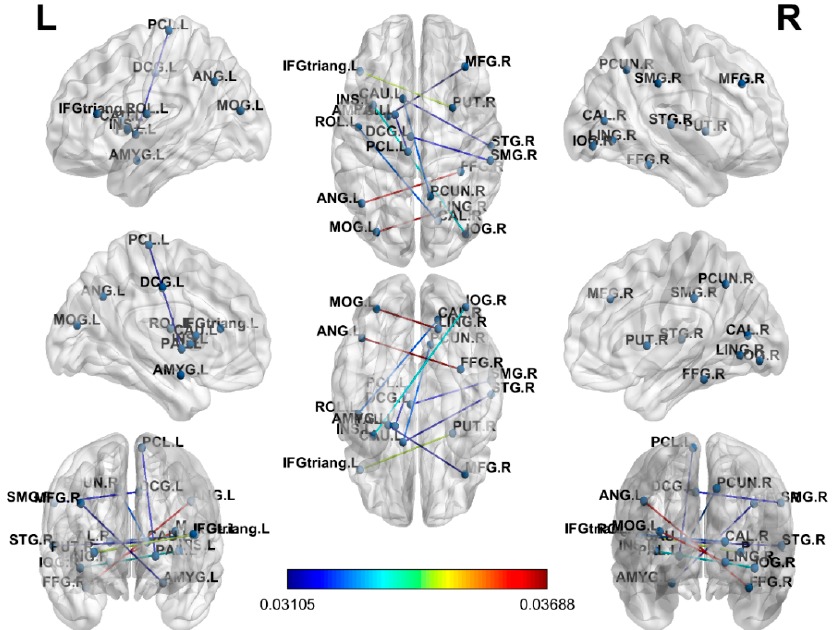
Figure 2. The weighted coefficients of the structural connections in the LR model. Warmer colors represent higher absolute values of the LR coefficients. A threshold of 0.03105 was set to reduce the connections for visual presentation. R: right; L: left; M: middle; A: anterior; P: posterior; S: superior; I: inferior; F: frontal; T: temporal P: parietal; O: occipital; G: gyrus.